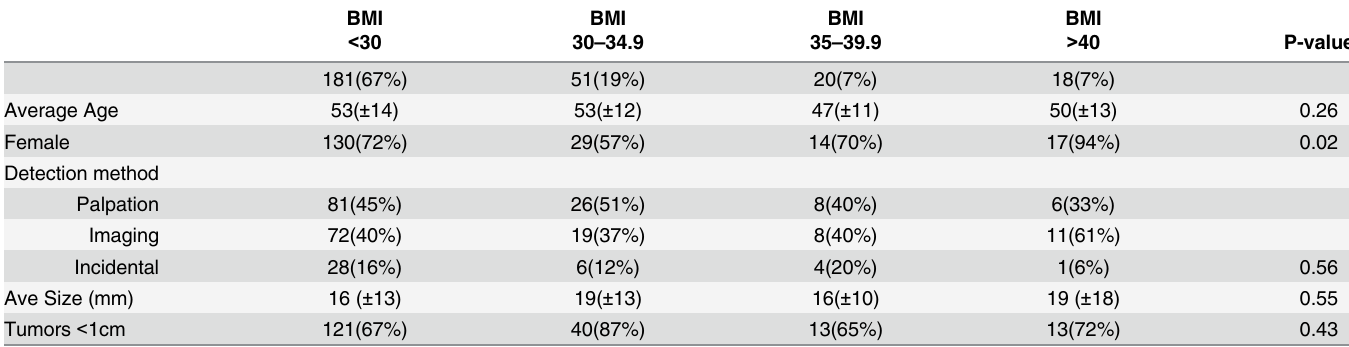
Table 3. Comparison of BMI